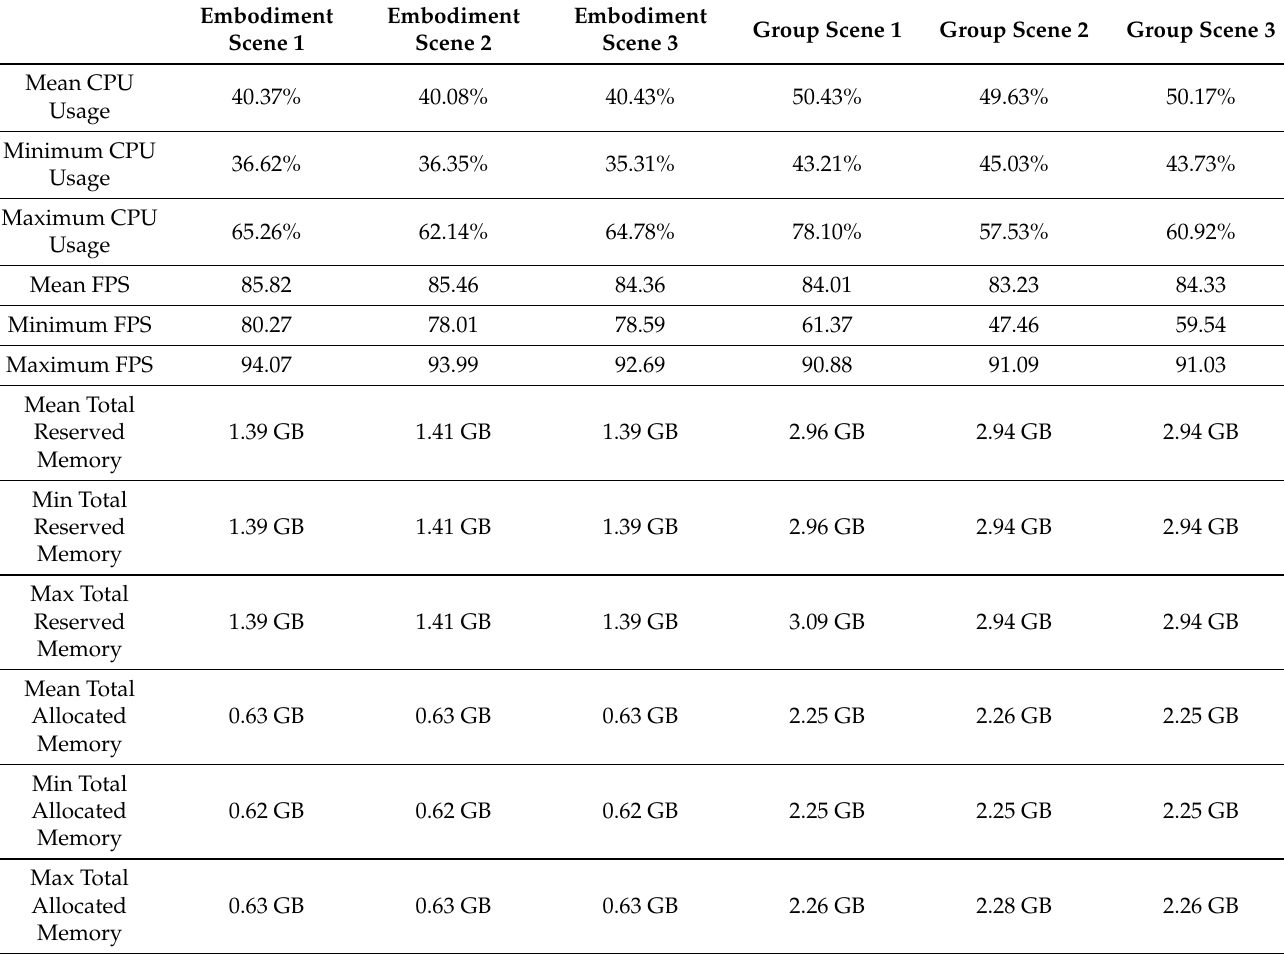
Table A9. Results for Test Condition 5: Facial Tracker.